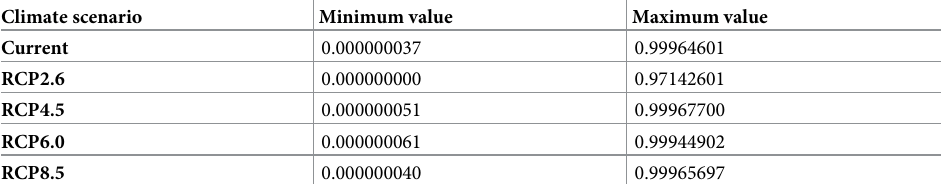
Table 2. The minimum and maximum values of the probability of an area being climatically suitable for Bactro- cera zonata predicted by the five models under different climatic scenarios ran in MaxEnt.